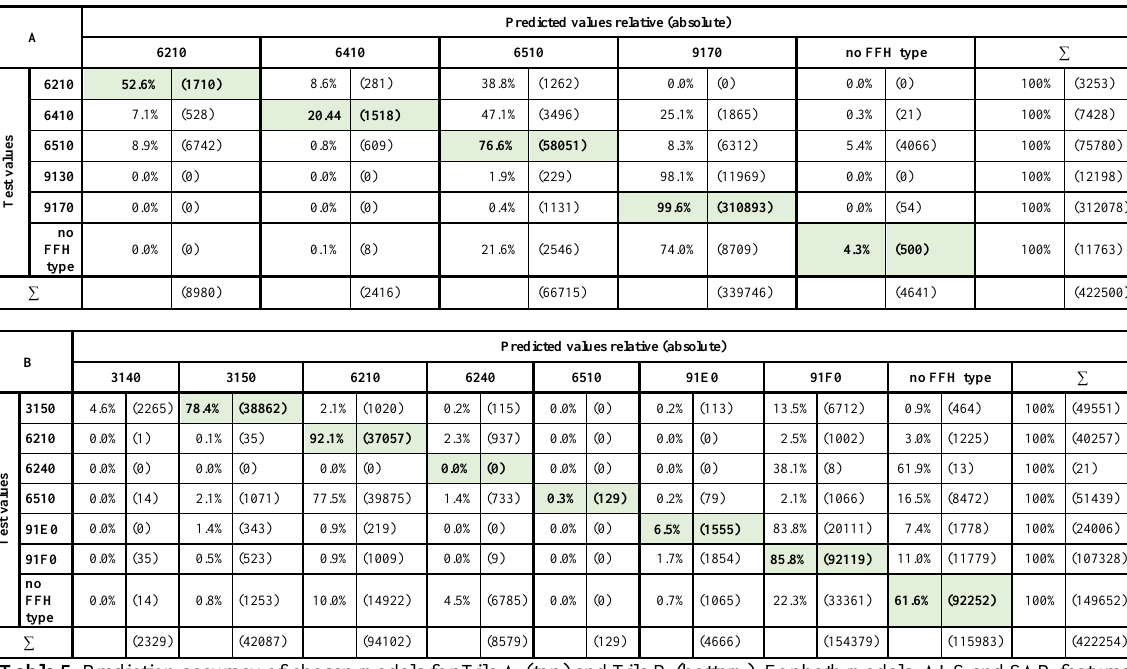
Table 5. Prediction accuracy of chosen models for Tile A (top) and Tile B (bottom). For both models, ALS and SAR features were used as predictors. Model A (top) was trained with a maximum depth of 5 and 500 trees. For model B (bottom), a maximum depth of 15 and 500 trees were